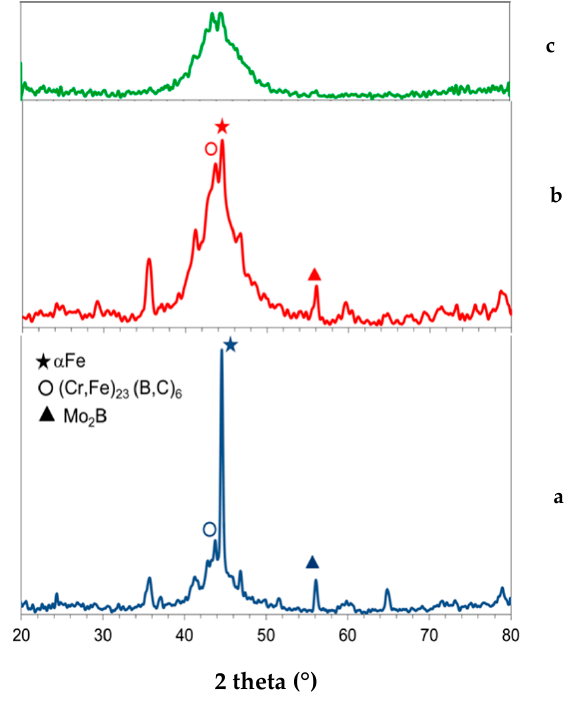
Figure 3. XRD patterns of ( a ) starting powder SHS7574; ( b ) HVOF-deposited coating; and ( c ) CGS-deposited coating.